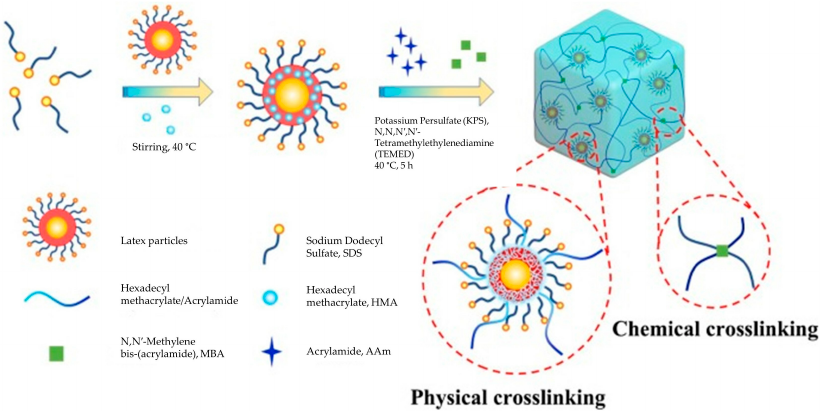
Figure 1. Scheme for synthetic process of hybrid hydrogels. Reproduced from [35] with permission from Elsevier, 2018.